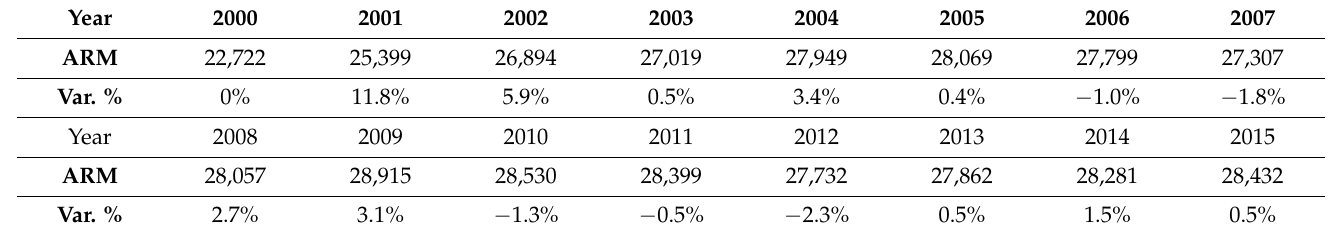
Table 2. Evolution of the accommodation offer by number of beds. (Source: Edited by